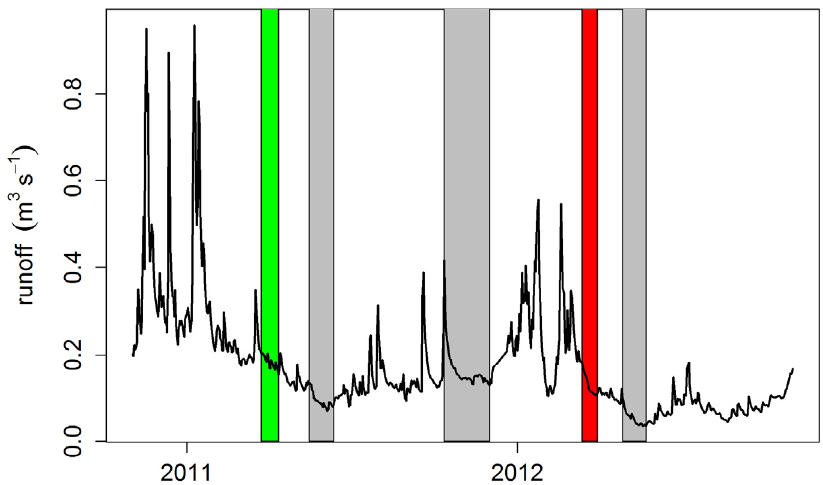
Figure 1. Runoff of the Koselmühlenfließ above the weir at the discharge gauge Q16 and selected time periods for calibration (red, 15 March–2 April 2012), validation (green, 24 March–12 April 2011), and scenario analyses (gray, 16 May–12 June 2011, 12 October–1 December 2011, and 26 April–22 May 2012).